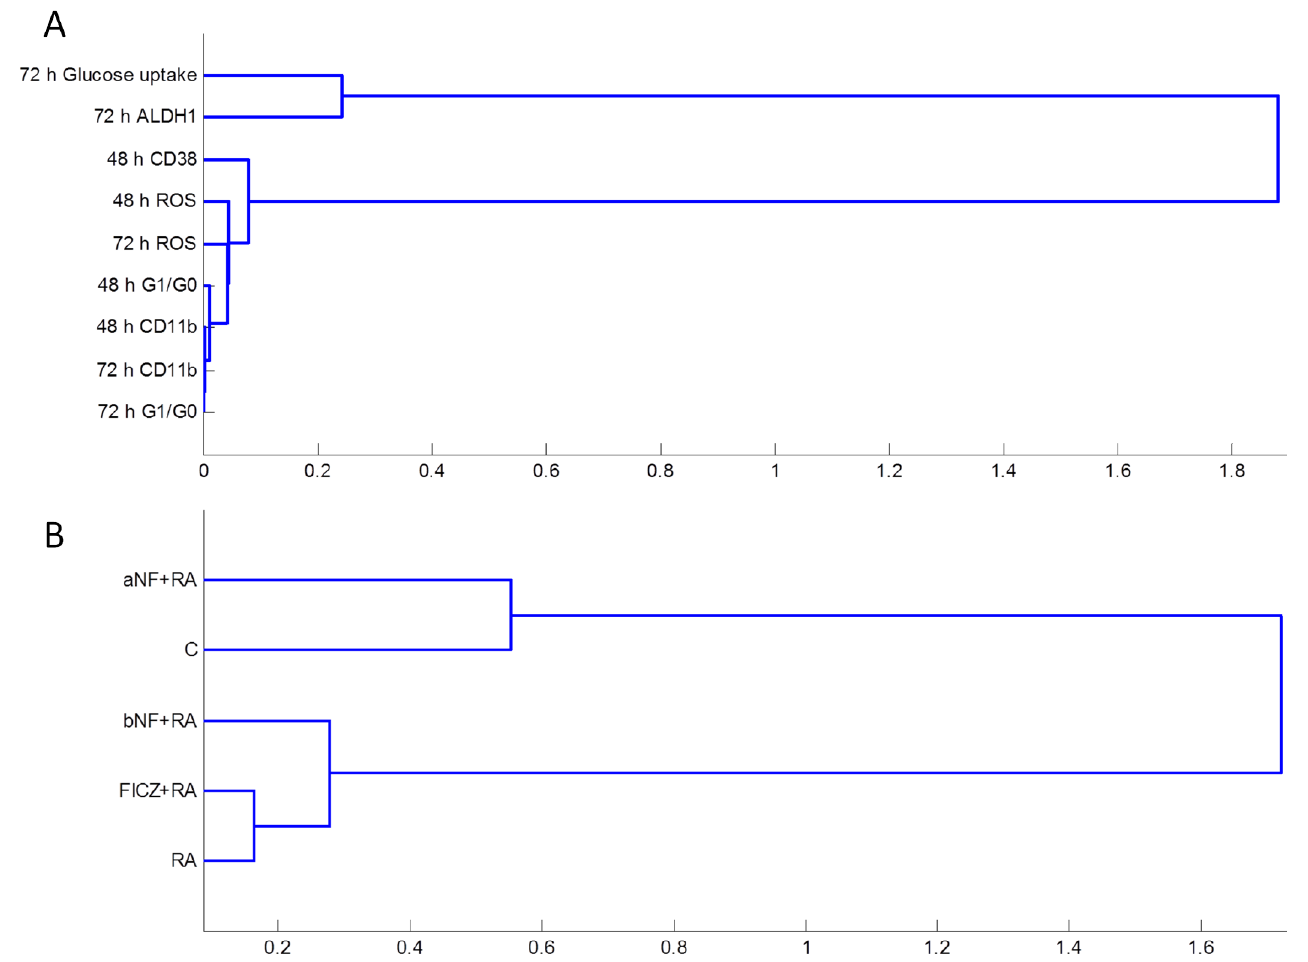
Fig 3. Hierarchical clustering between phenotypic markers (A) and treatments (B). The phenotype data was subject to hierarchical clustering analysis using the Pearson correlation coefficient as a distance metric and the average linkage method. Distances between clusters (1-Pearson correlation coefficient) are indicated on the